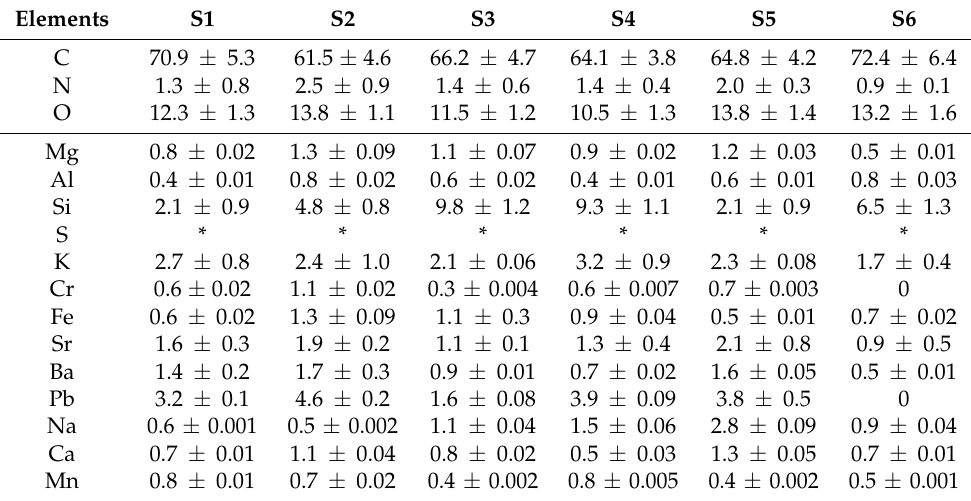
Table 3. Concentration of constituents in the turmeric samples using CF-LIBS in weight %.